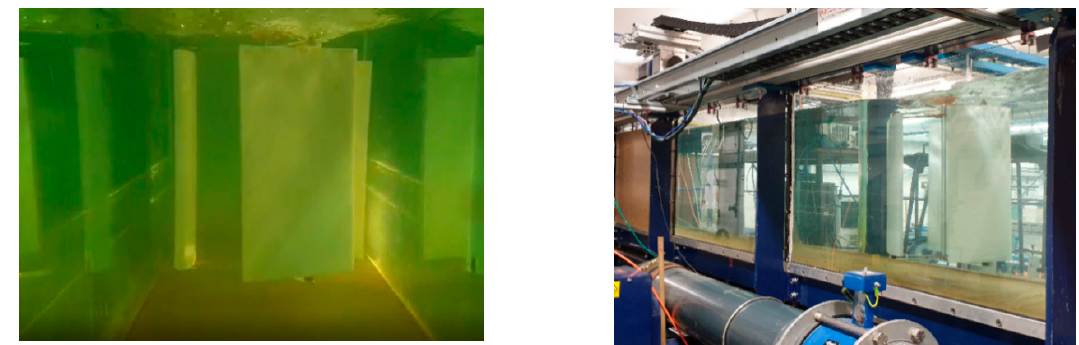
Figure 6. Measurement system for the DH turbine.